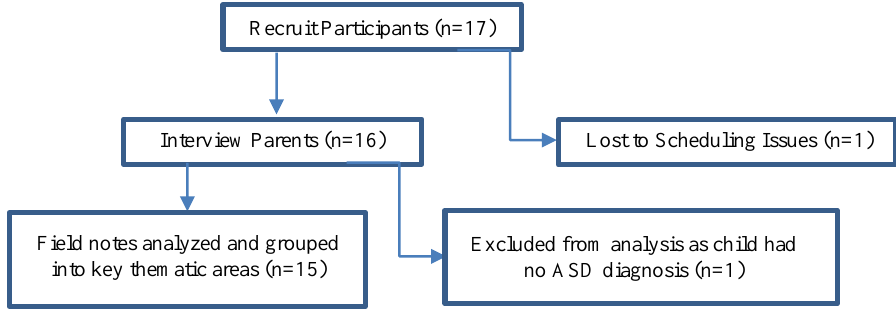
Figure 1. Methods Flow